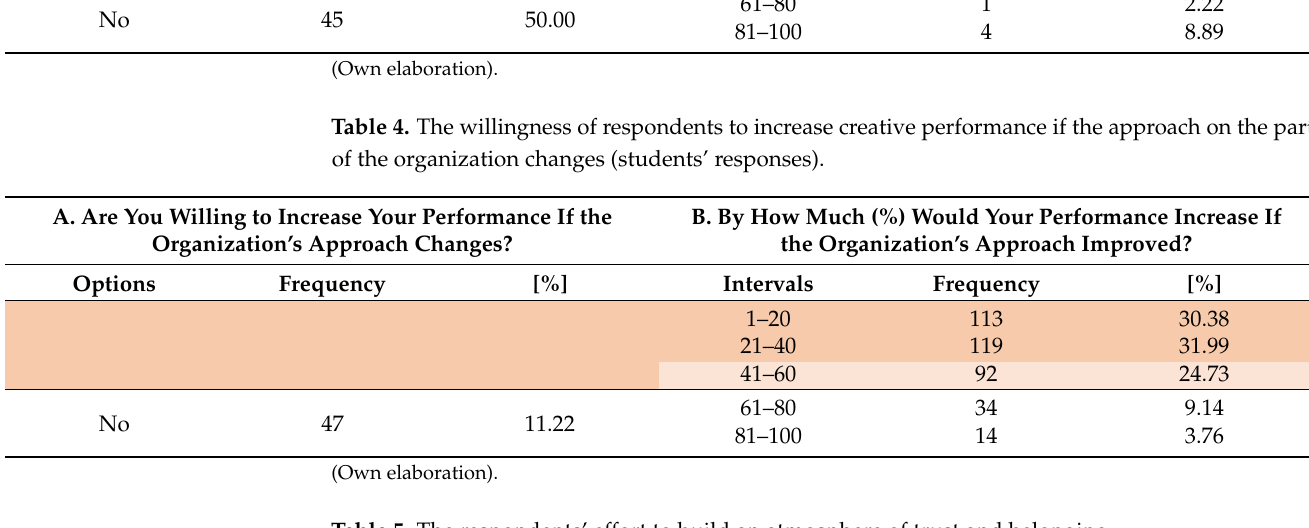
Table 5. The respondents’ effort to build an atmosphere of trust and